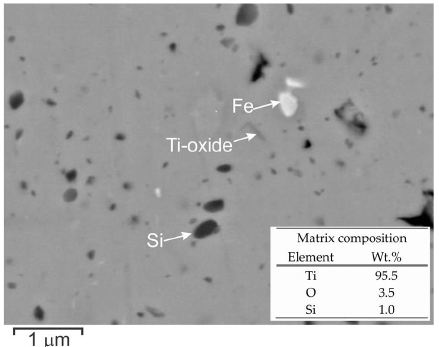
Figure 2. ( a ) XRD patterns of mechanically alloyed powders; ( b ) crystallite size as function of milling time.